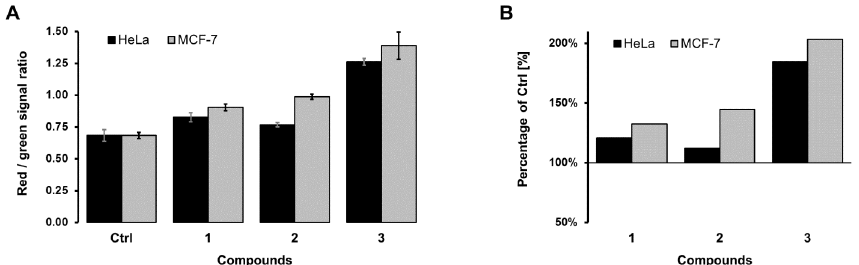
Figure 5. Double fluorescent staining of MCF-7 cell samples after 24 h treatment with extracts (DE, SWE) and resveratrol (RSV): control ( A ), dry extract ( B ), subcritical water extract ( C ) and resveratrol ( D ). Stained cells were photographed with an Olympus Camedia 3040 digital camera mounted on an Olympus BX51 microscope with a 10× magnification lens. Different intensities of fluorescent signals of the two colors can be observed.